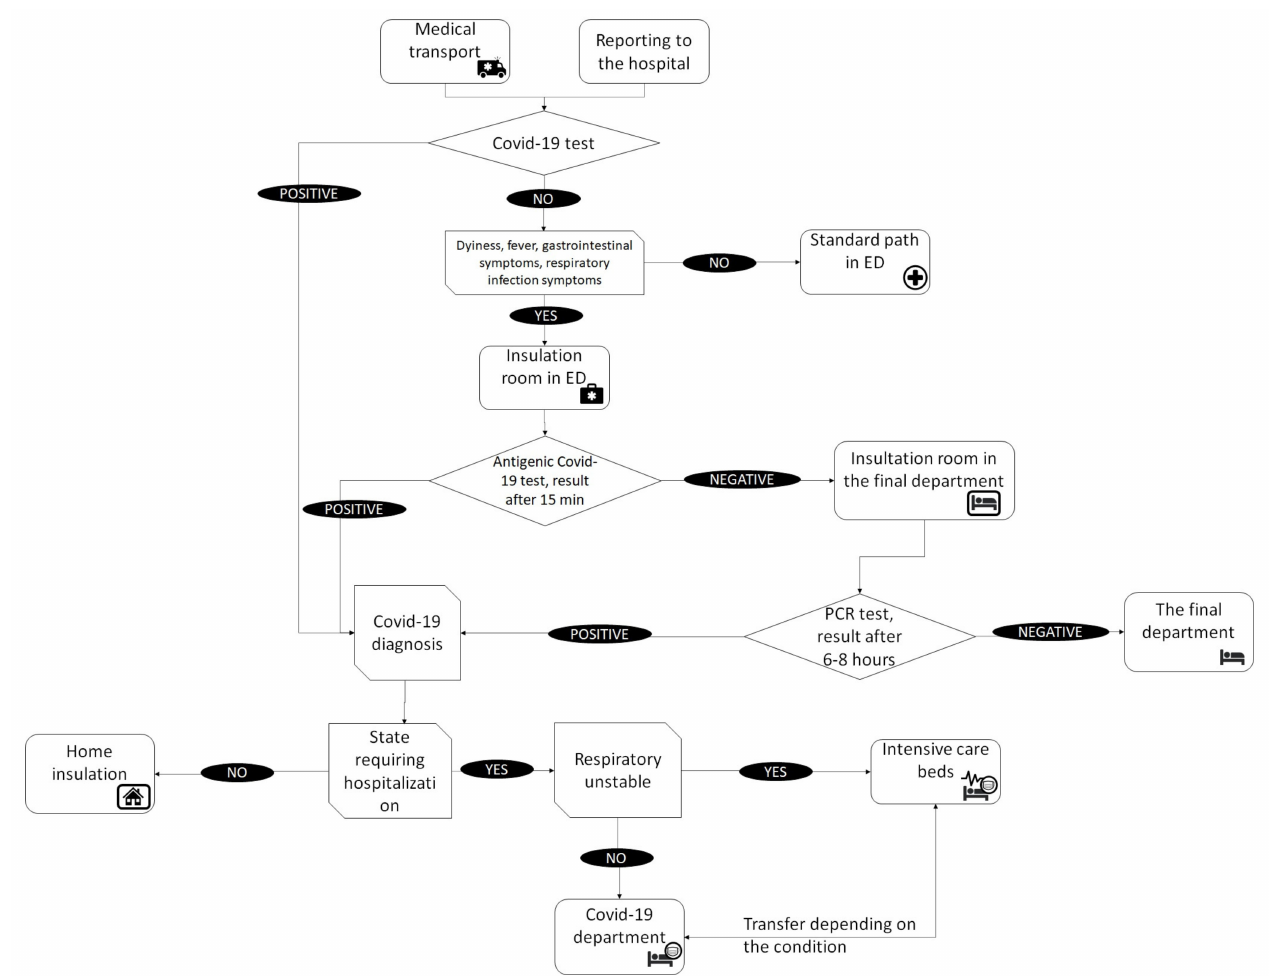
Figure 5. Triage procedure source: Hospital internal